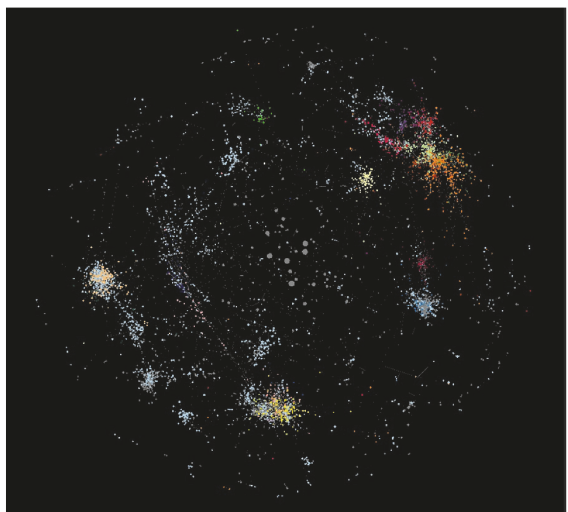
Figure 6: Graph-based representation of processes space in healthcare (interactive view) (Demonstration available at https://www.youtube